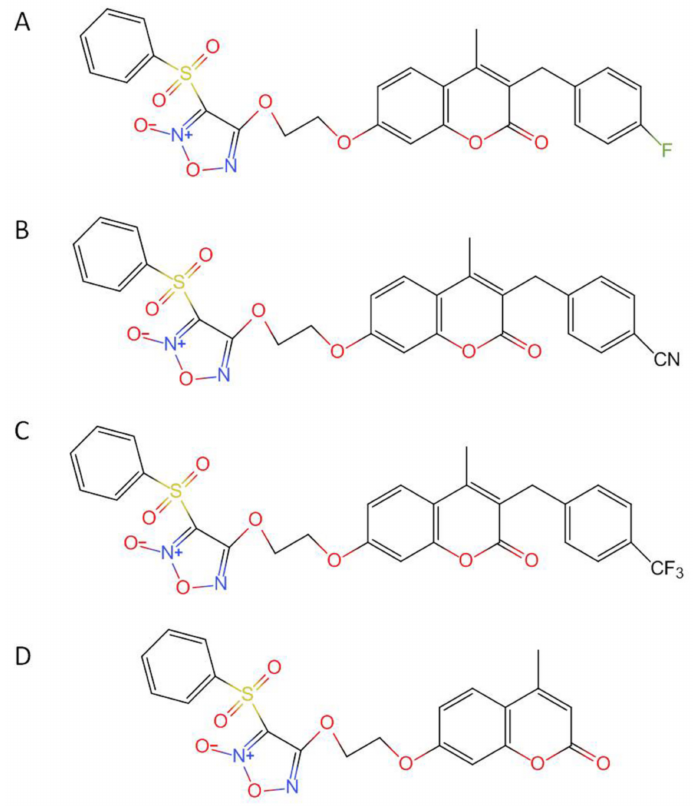
Figure 6. Structures of CY-14S-4A83 ( A ), CY-16S-4A43 ( B ), CY-16S-4A93 ( C ), and IS ( D